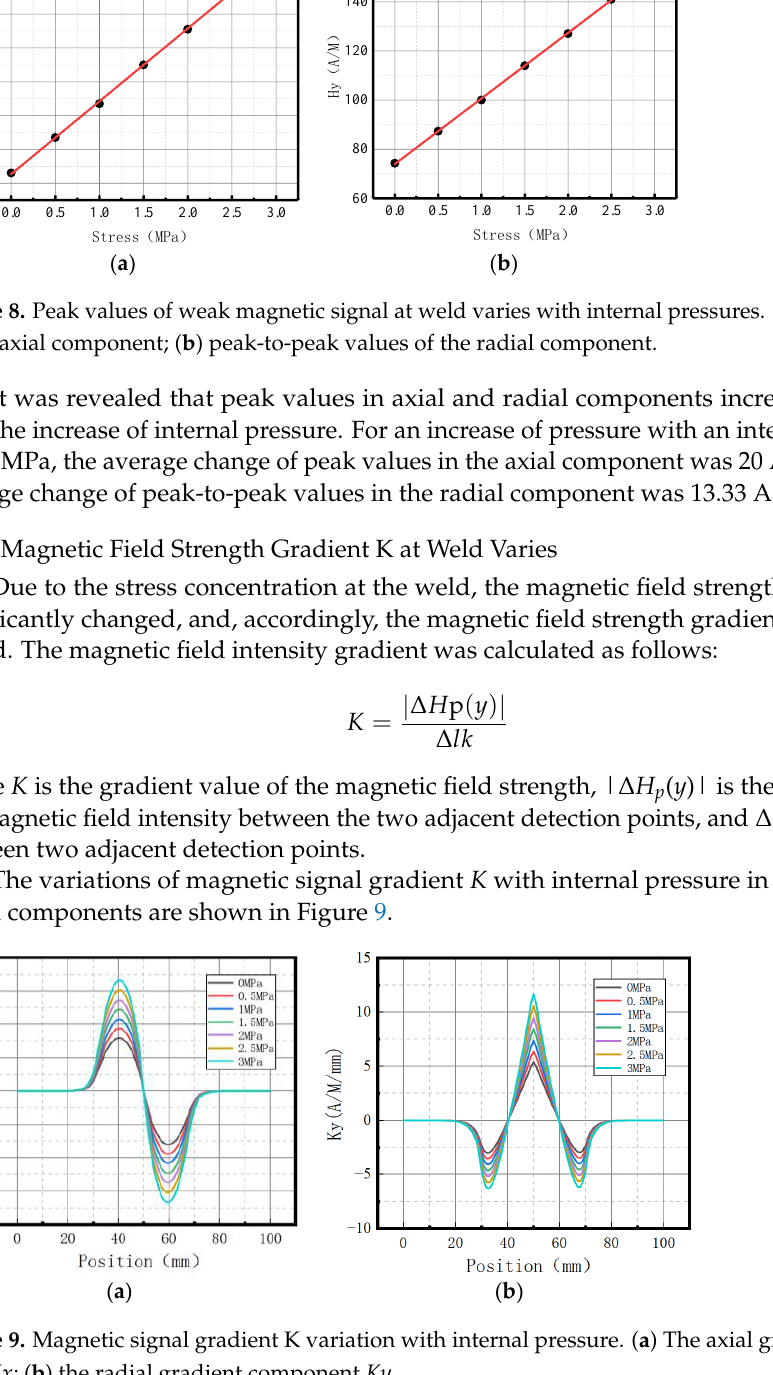
Figure 7. Magnetic signal of weld under different internal pressure. ( a ) Axial component of weak magnetic signal; ( b ) radial component of weak magnetic signal.